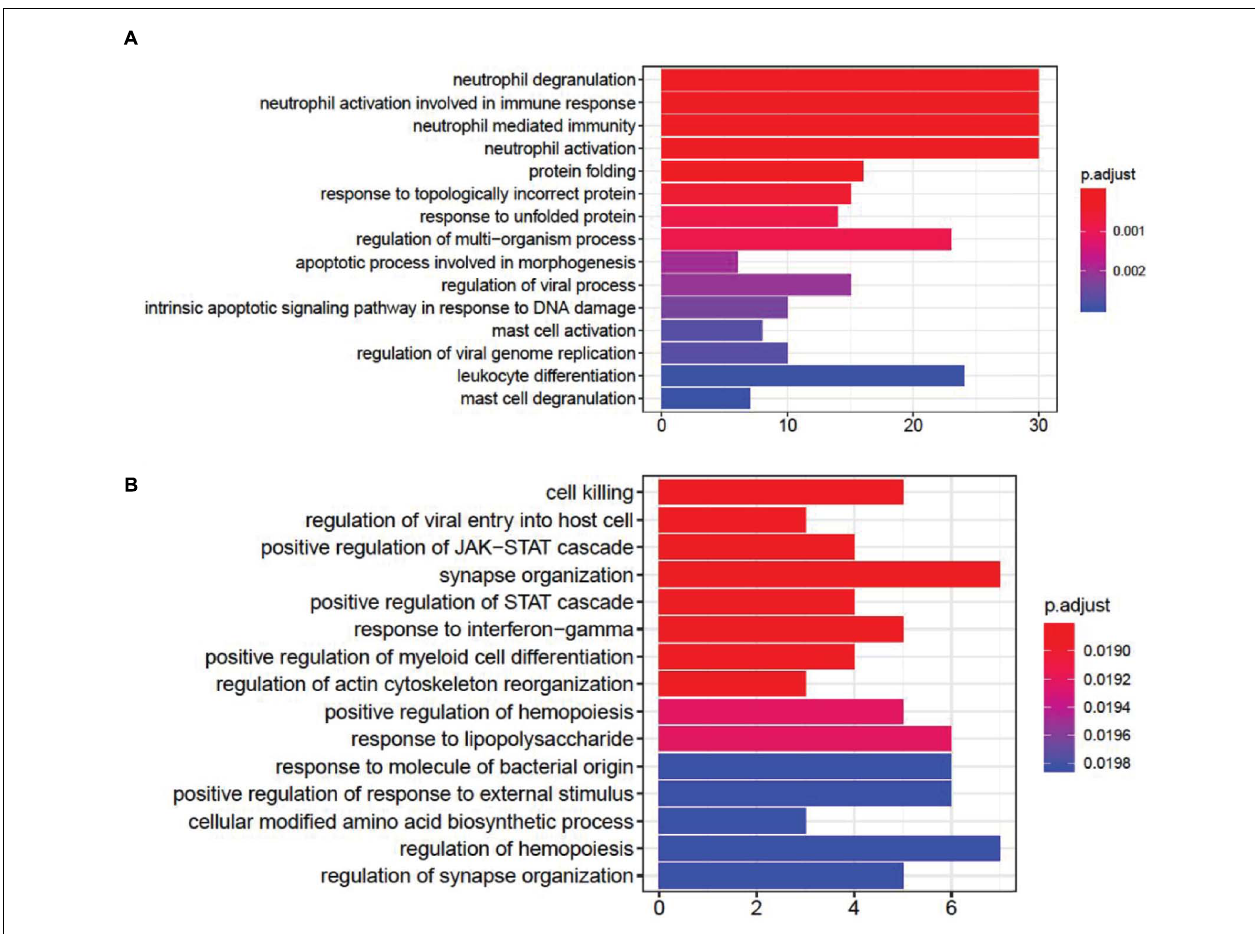
FIGURE 2 | Gene ontology enrichment analysis of differentially expressed genes (DEGs) associated with fever. (A) and infection (B) . We found that DEGs associated with fever are enriched in immune- and apoptotic-related pathways, whereas DEGs associated with infection are enriched within synapse-related